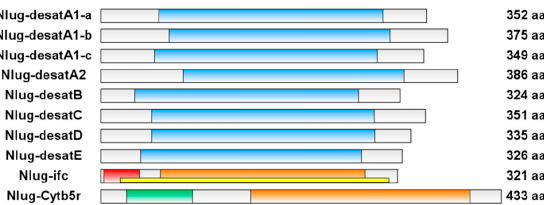
Figure 1. Schematic diagram of the domain architecture of 10 Nilaparvata lugens desaturase (Nlug-desat) genes. The deduced amino acid (aa) sequences were used to predict the domain architecture of Nlug-desats with Batch CD-search (National Center for Biotechnology Information) and InterProScan. The blue boxes indicate the ∆ 9-fatty acid desaturase-like domain ( ∆ 9-FADS-like, cd03505). The red and the yellow box indicates the sphingolipid ∆ 4-desaturase, N-terminal (IPR013866) and ∆ 4-sphingolipid fatty acid desaturase-like domain ( ∆ 4-sphingolipid-FADS-like, cd03508), respectively. The green and the orange box indicate the cytochrome b5-like heme/steroid binding domain (Cyt-b5, pfam00173) and the fatty acid desaturase domain (IPR005804),